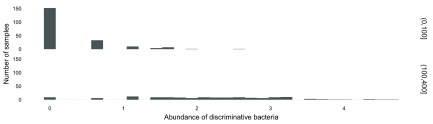
A bacteria in genus
Roseburia becomes much more abundant in the 100 to 400 day bin.